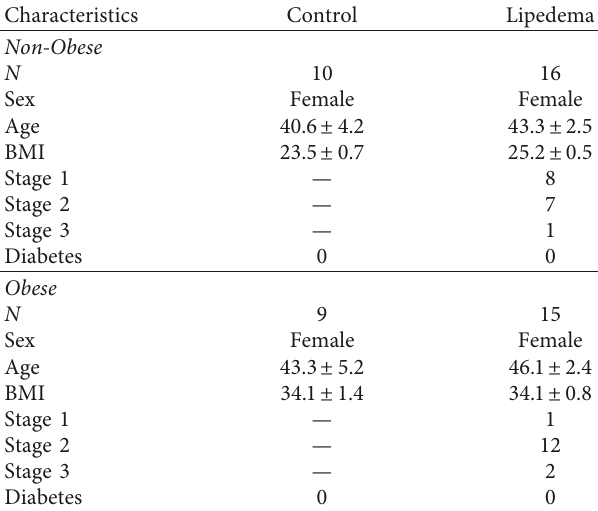
Table 1: Characteristics of control and lipedema